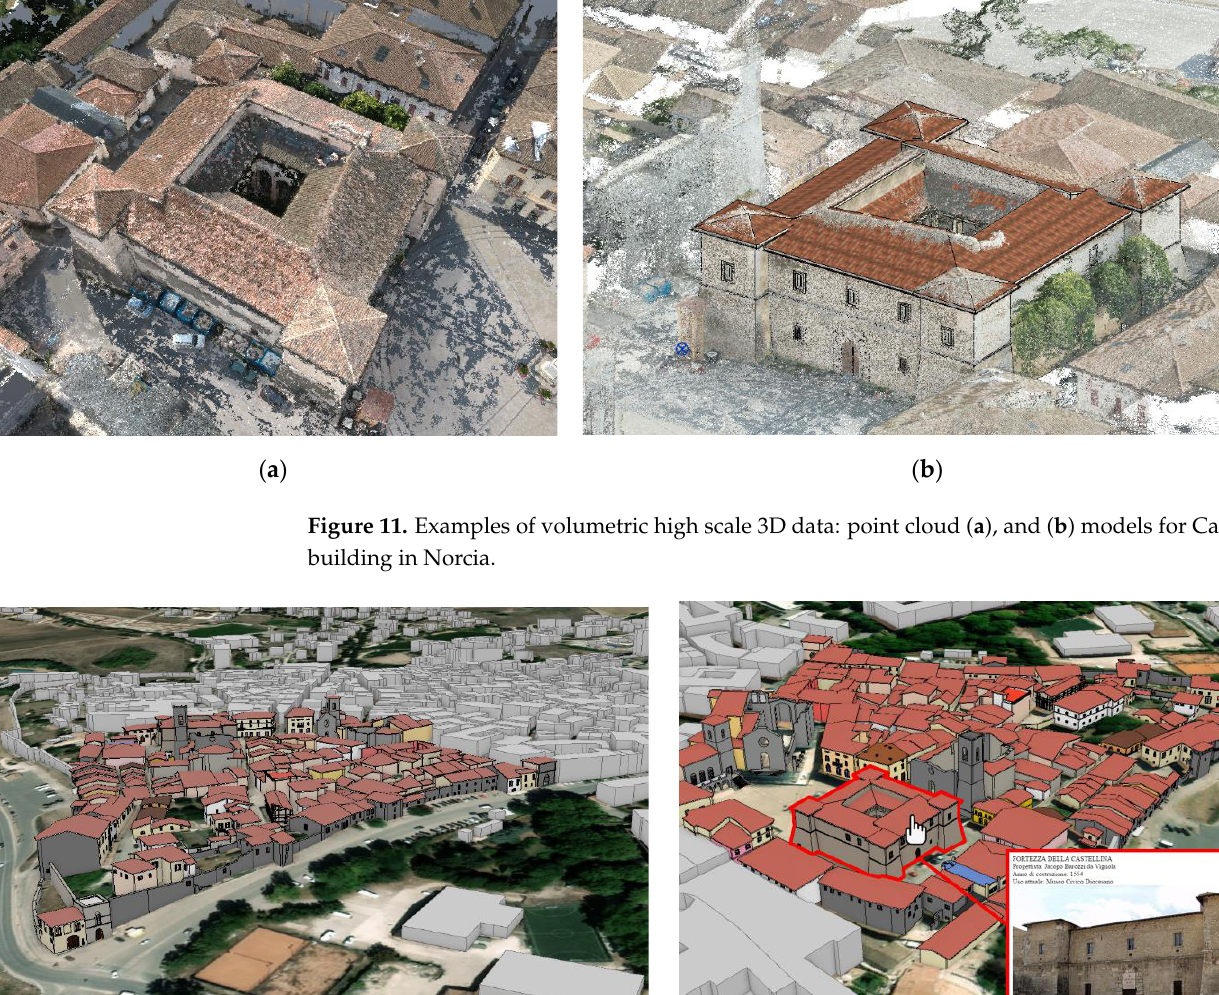
Figure 10. ( a ) Investigation of the anterior portion through the 3D mesh model textured by HD UAV images. ( b ) Recognition of the different portions of masonry not clamped or separated by cracks.